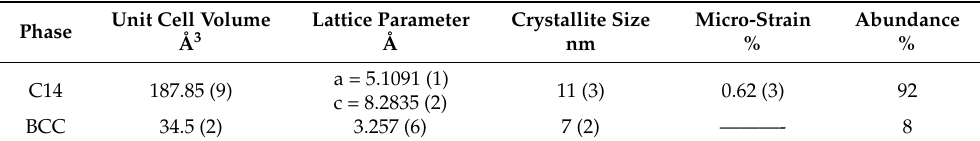
Figure 5. XRD patterns of the hydride sample. Table 4. Crystal structure parameters and abundance of each phase in the hydride sample. Error on the last significant digit is indicated in parentheses.